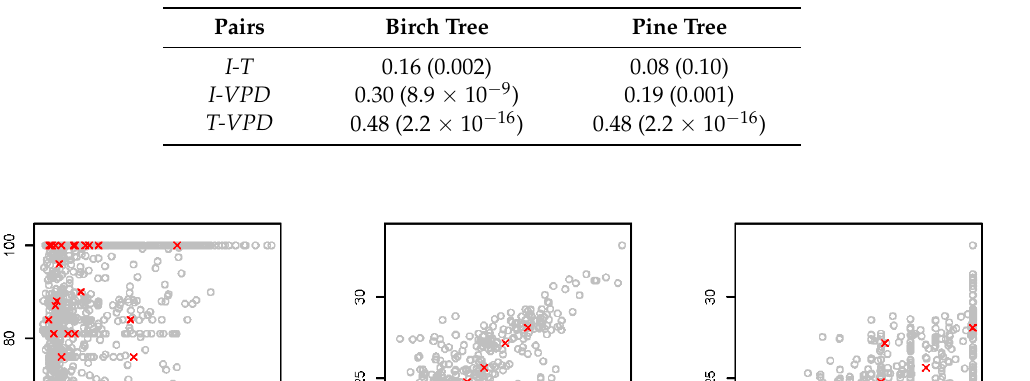
Table 3. Kendall’s correlation coefficients between pairs of the following variables: interception loss ( I ), air temperature ( T ) and vapour pressure deficit ( VPD ) for birch and pine trees calculated using 175 events. p -value is shown in brackets.